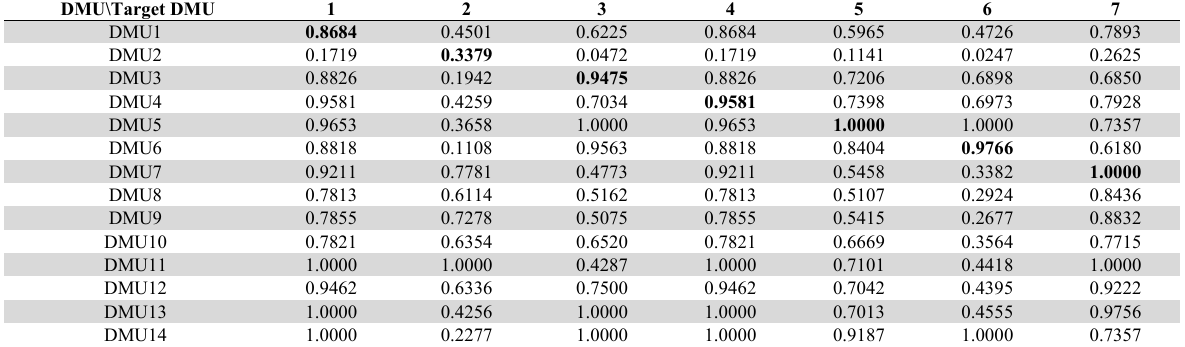
The combined CEM for fourteen international passenger airlines DMU\Target